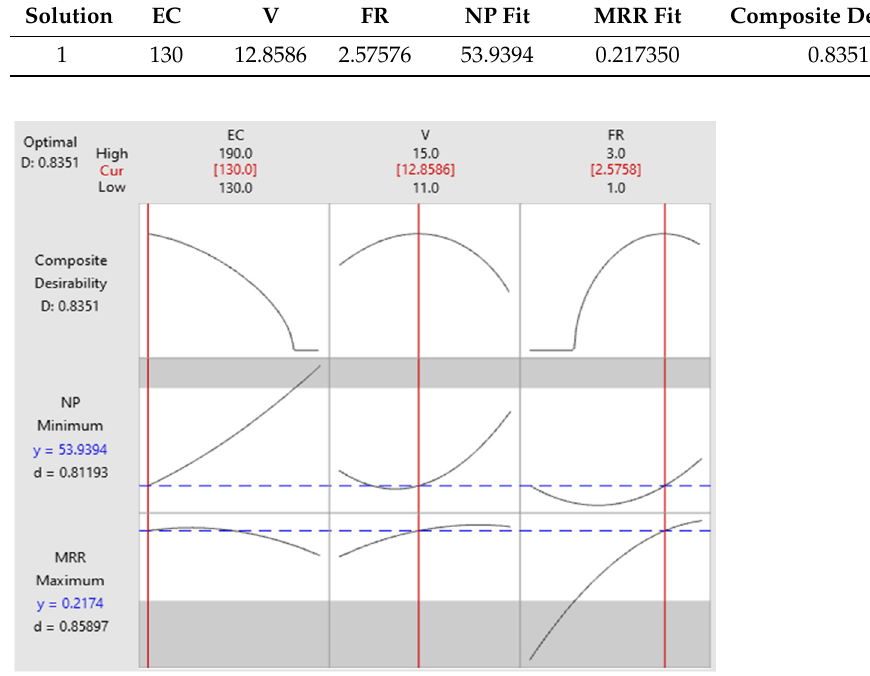
Figure 11. Response optimization